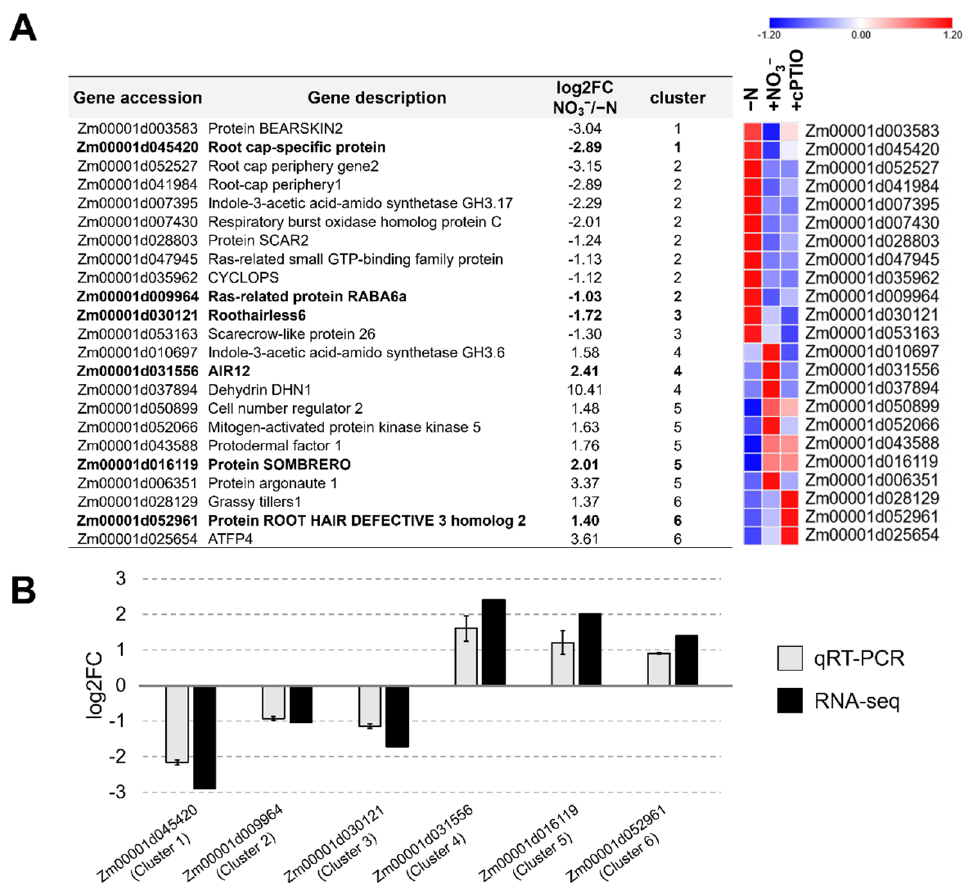
Figure 6. Validation of RNA-seq data by Real-time PCR (qRT-PCR). ( A ) Heat map of expression changes in pairwise comparison between − N (control), +NO 3 − and +cPTIO treated roots, for 23 randomly selected differentially expressed genes (DEGs) among all the six clusters. DEGs normalized z-scaled expression values are reported in a blue to red color scale (blue: lower RPKM values, red: higher RPKM values). In bold are highlighted the six genes used for qRT-PCR. ( B ) Six representative genes were chosen to validate the RNA-seq data by qRT-PCR. The gray bars represent mean values of the log2 fold-change ratio (log2FC) among NO 3 − / − N samples obtained from three biological replicates of qRT-PCR, with error bars reporting the standard errors, while the black bars represent the RNA-seq data. RPKM, Reads Per Kb per Million.